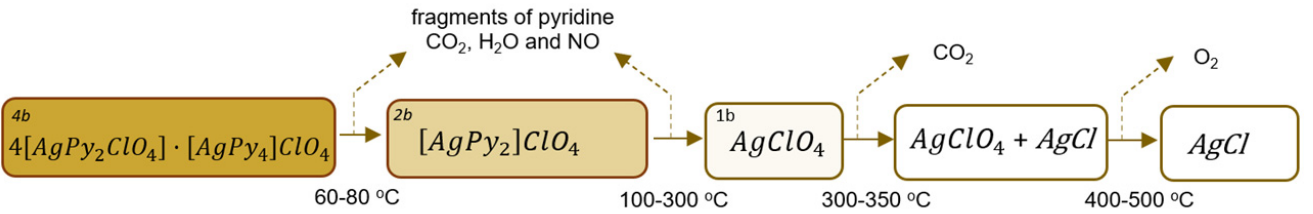
Figure 5. Proposed mechanism for the thermal decomposition of 4b in argon [13].